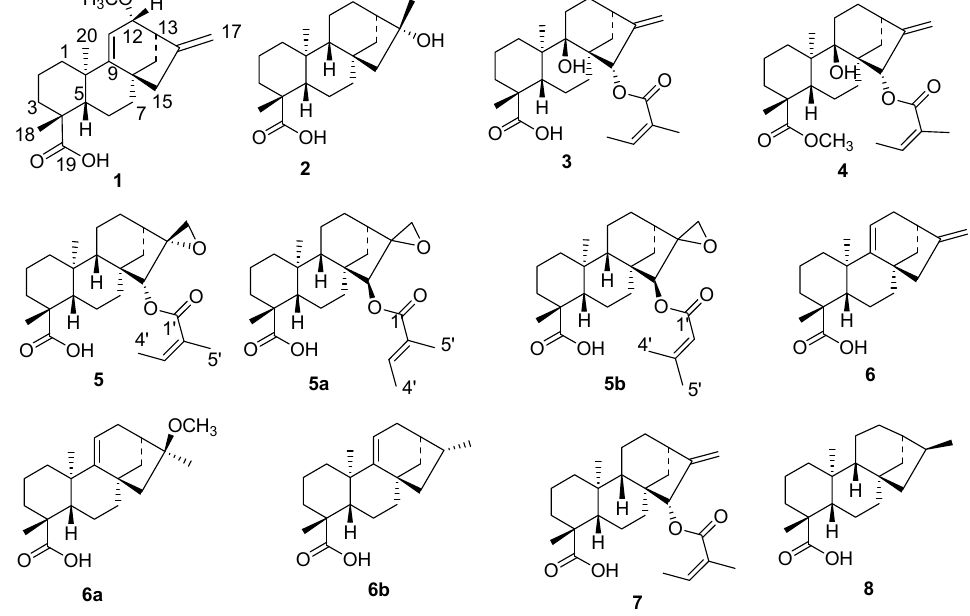
Figure 1. Structures of compounds 1 – 8 .